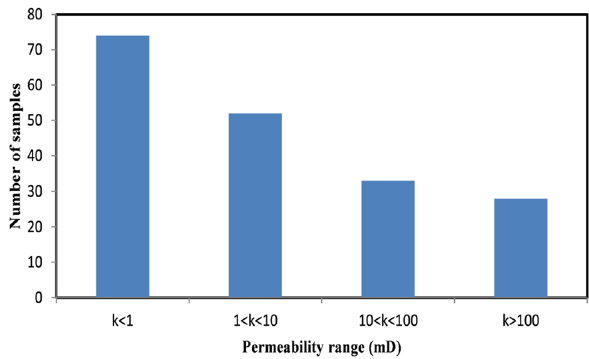
Fig. 1 Permeability distribution of the samples